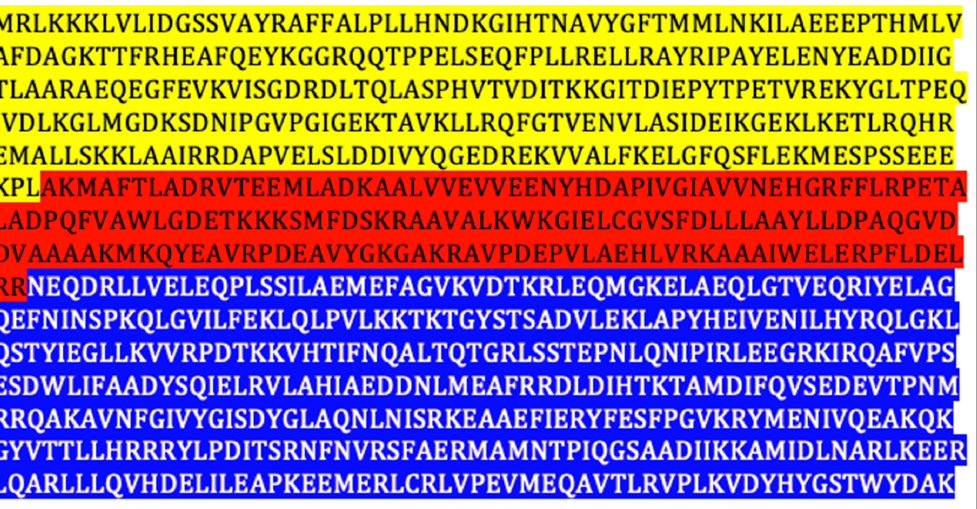
Figure 1. Amino acid sequence of the SK72 DNA polymerase I. Note: 5 ′ -3 ′ exonuclease domain (blue region), 3 ′ -5 ′ exonuclease domain (red region), and 5 ′ -3 ′ polymerase domain (yellow region).